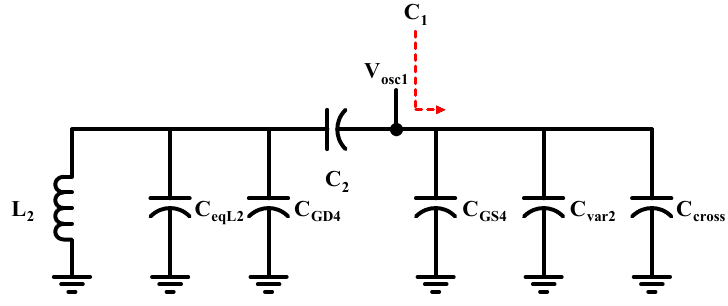
Figure 4. Half-circuit of the proposed voltage controlled oscillator.